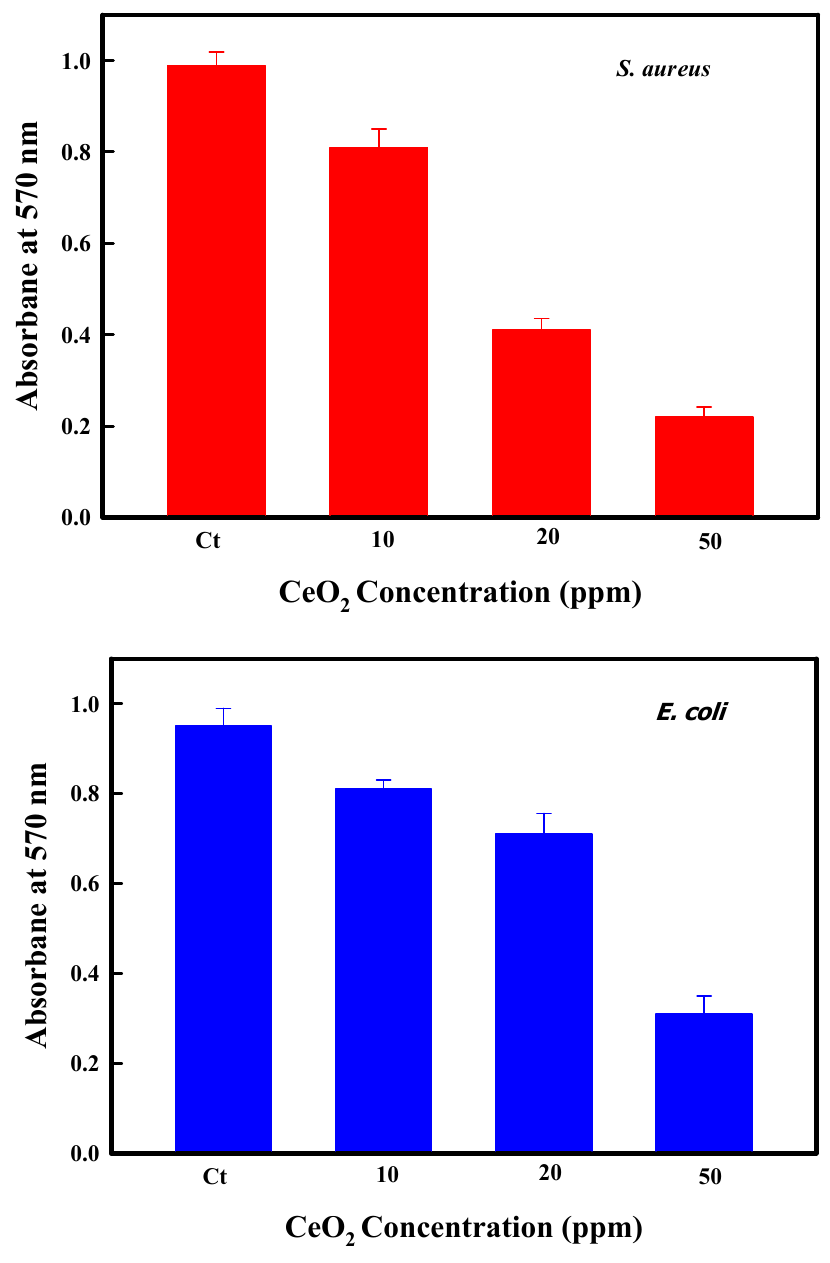
Figure 8. Inhibition on E. coli and S. aureus biofilm formation at different concentrations of CeO 2 NPa.